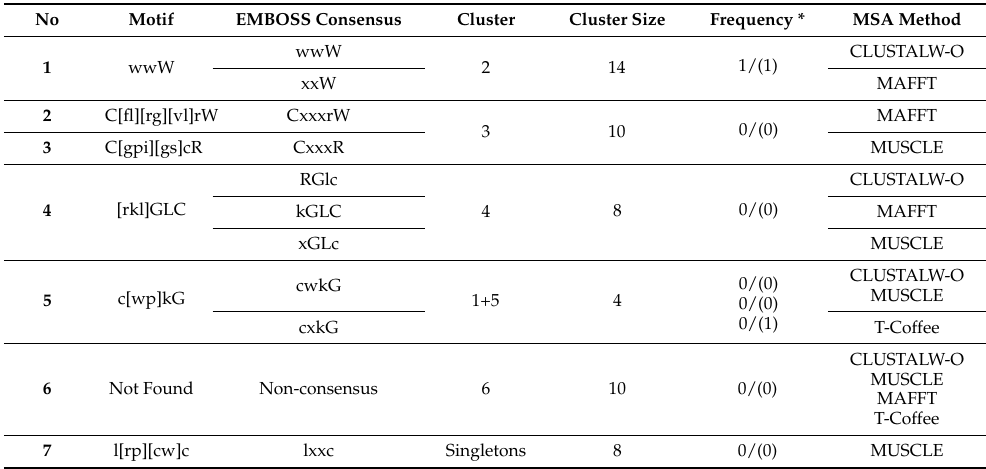
Table 6. Discovered motifs by Multiple Sequence Alignment